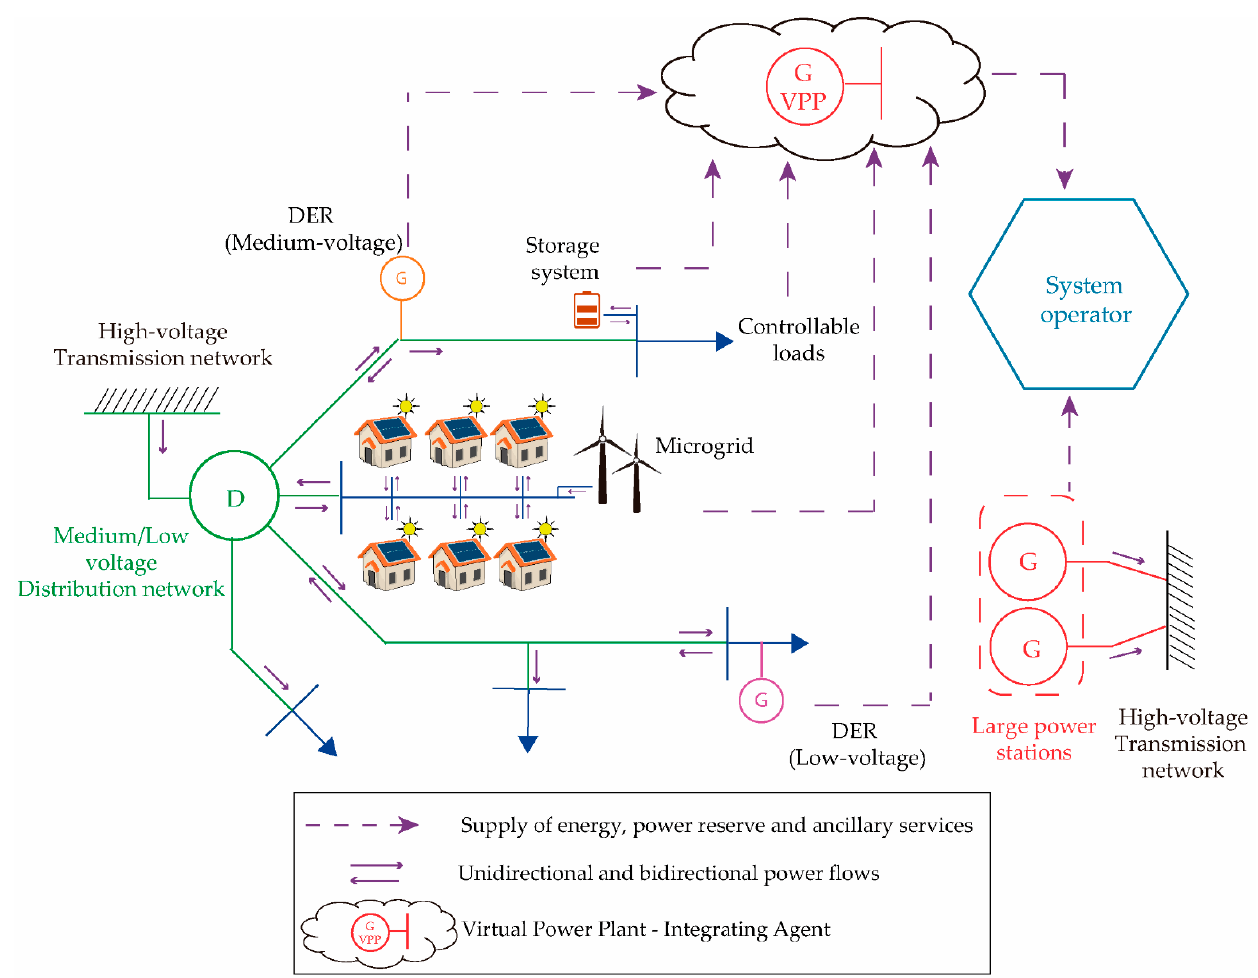
Figure 3. Scheme of the proposed definition of VPP .